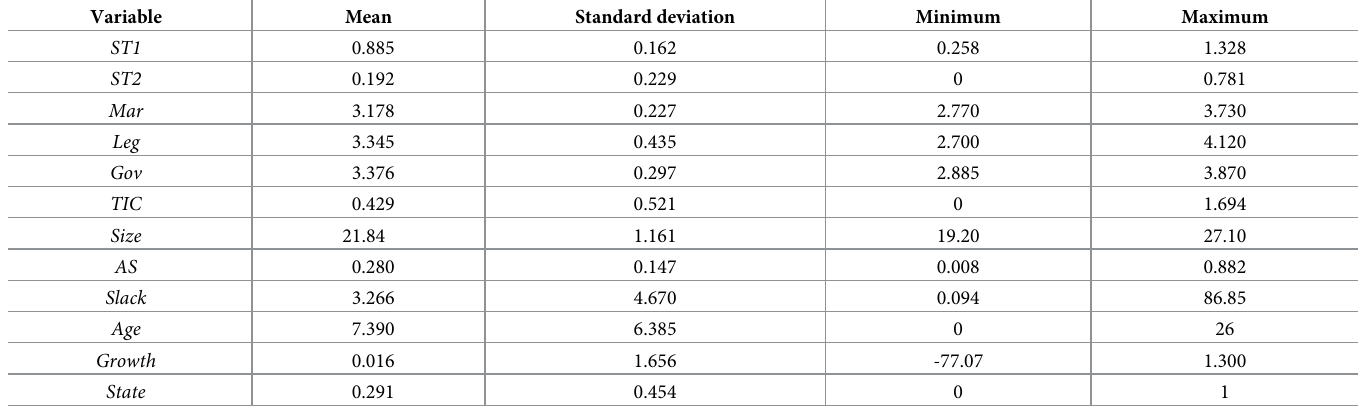
Table 2. Descriptive statistical